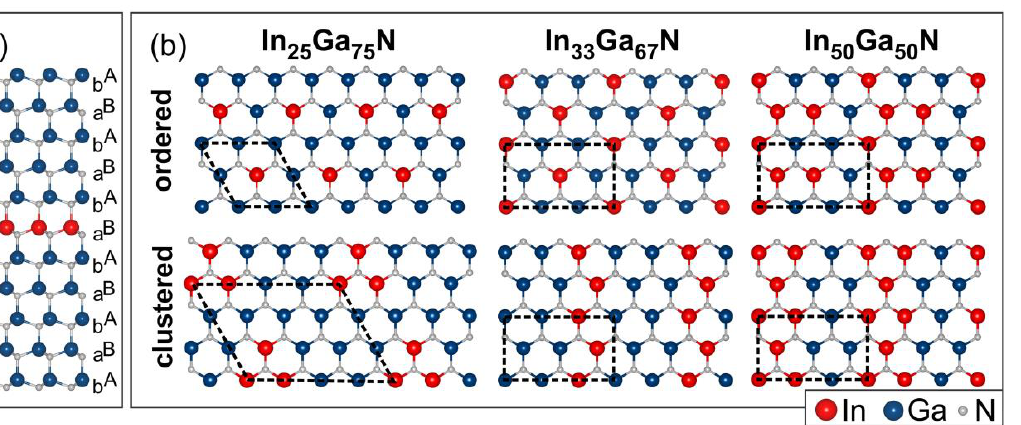
Figure 1. ( a ) Cross - sectional schematic illustration of InN quantum well with one monolayer thickness in (0001) - oriented GaN barriers (projection along [112̅0] ). The monolayer can be bA or aB. The material is shown with metal polarity consistent with experimental growths. ( b ) Plan-view illustrations of ordered and clustered configurations of (0002) In x Ga 1 − x N monolayers, for structures up to indium content of x = 50%. Higher compositions of 67% and 75% can be obtained from the respective 33% and 25% ones by the interchange of indium with gallium atoms.